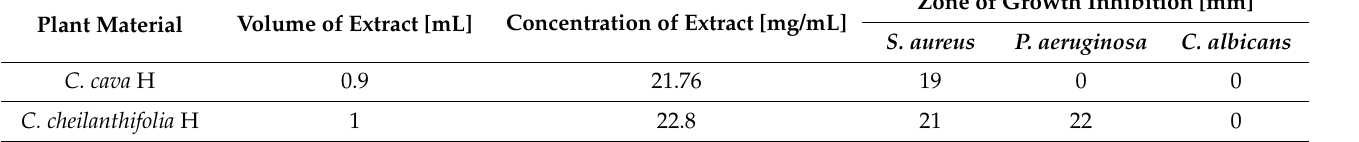
Table 5. Diameters of growth inhibition obtained by the disc diffusion method (mm). The diameters of the cellulose membranes were 14 mm. The release of extracts other than those obtained from C. cheilanthifolia H and C. cava H did not translate into the formation of the zone of growth